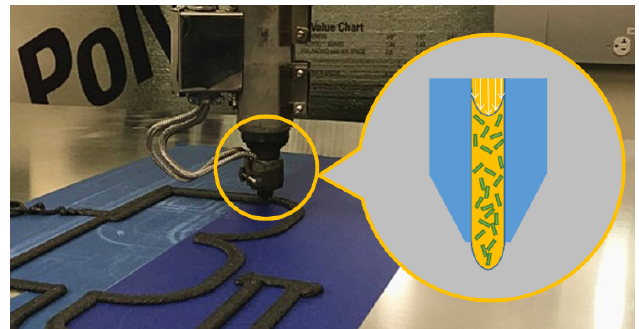
Figure 1. Manufacturing 13 wt.% CF/ABS with a Large-scale extruder-based PDAM system.